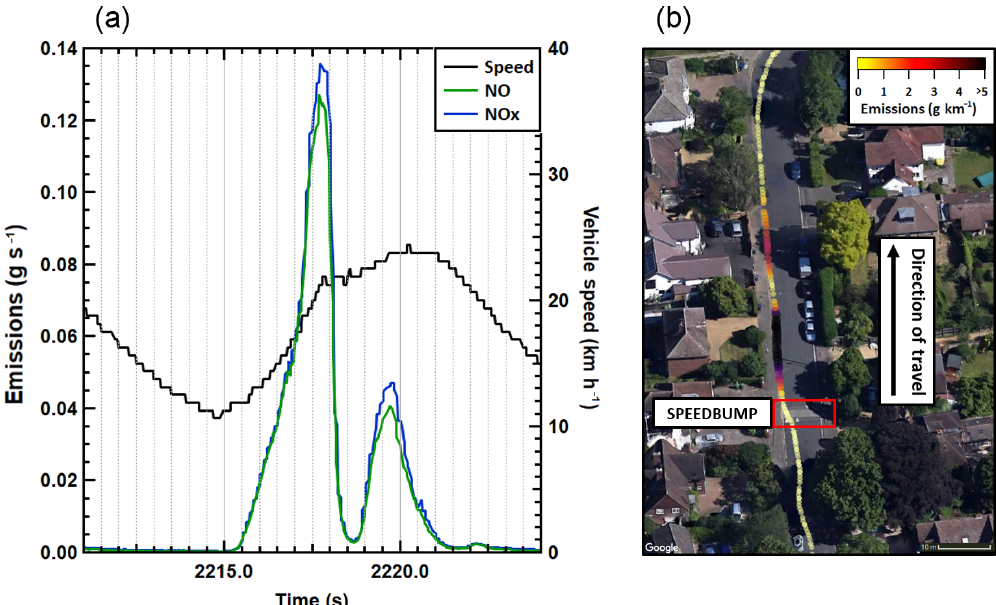
Figure 6. Panel (a) NO x and NO emissions in gs − 1 with vehicle speed, showing the transient behaviour associated with driving over a single speed bump in detail. The geolocation plot in panel (b) shows the emissions in gkm − 1 associated with the vehicle’s negotiation of the speed